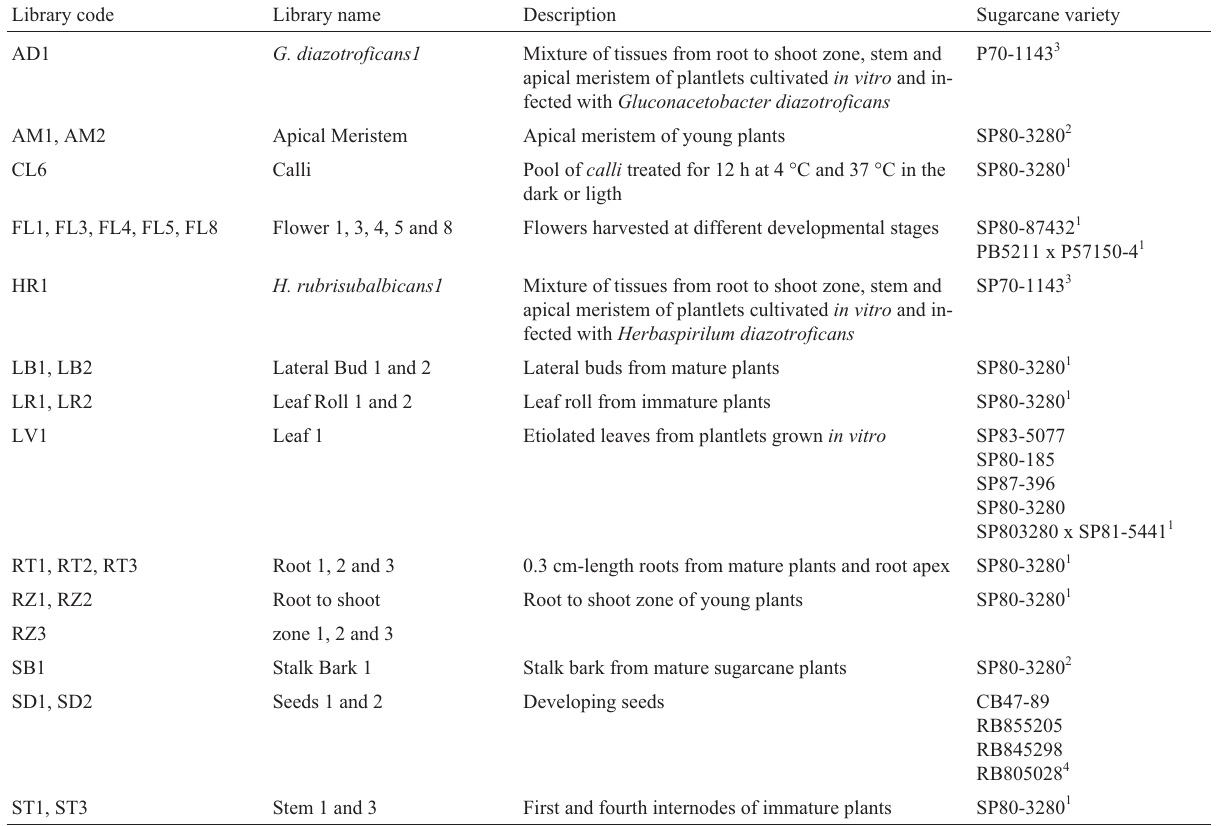
Table I - Description of the SUCEST